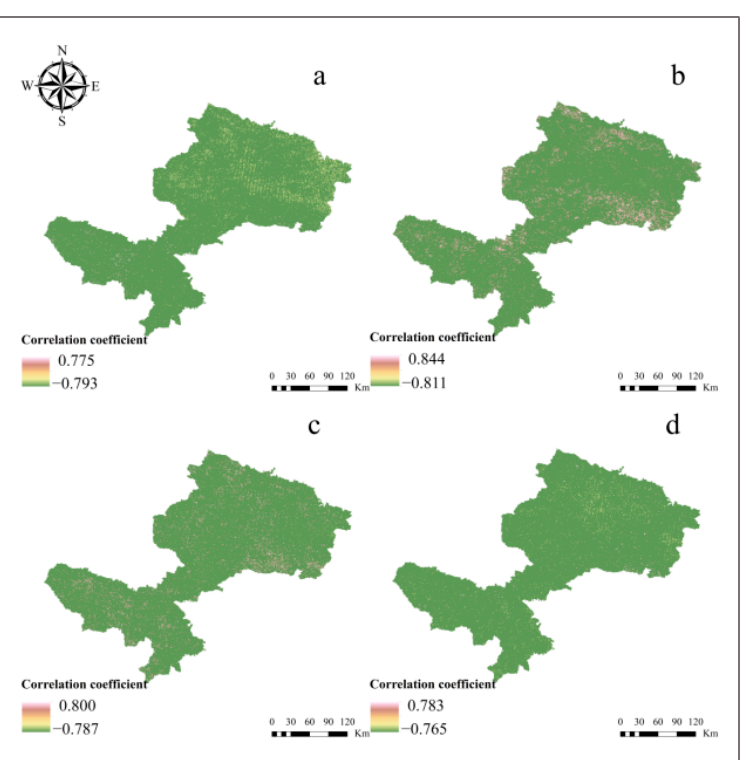
Figure 5. Spatial distribution of the correlation between pH and NPP in summer during 2000–2021: ( a ) the correlation in summer, ( b ) the correlation in June, ( c ) the correlation in July, and ( d ) the correlation in August. Table 3. Correlation of pH and NPP in summer during 2000–2021.